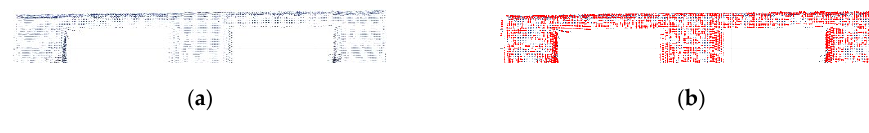
Figure 9. ( a ) The source point cloud. ( b ) The key points of source point cloud.